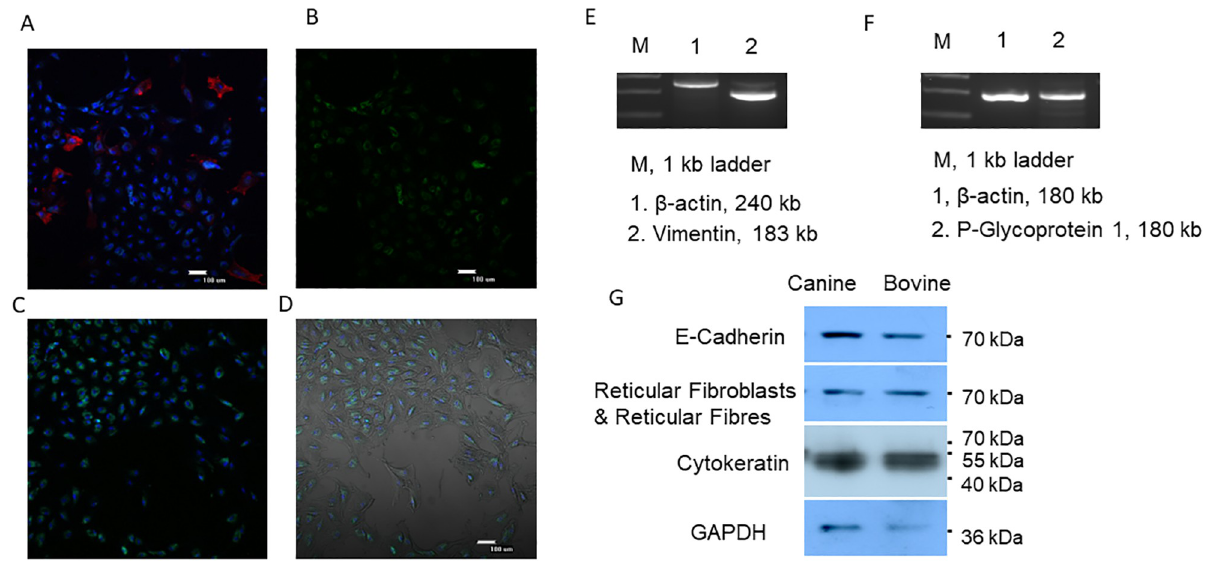
Fig 3. UDC immunohistochemical characterization with Hoechst indicating nuclei (Blue) A) Vimentine positive cells (Red) B) E-Cadherin positive staining(Green) C Pancytokeratin stain (Green). D. Pancytokeratin stain overlaid on light microscopy image. E) Presense of Mesynchymal cellular marker Vimentin, F) Epithelial marker P-Glycoprotein. G Further markers for cell characterization indicating a heterogeneous cell population in